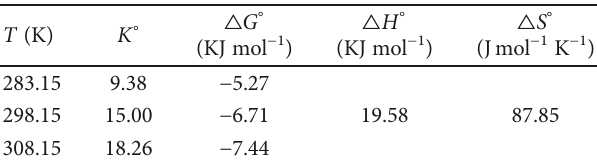
Figure 6: Thermodynamic parameters fi tting curve of ln(K ° ) versus 1/T. Table 5: Thermodynamic parameters for the adsorption of Cu(II) in aqueous onto